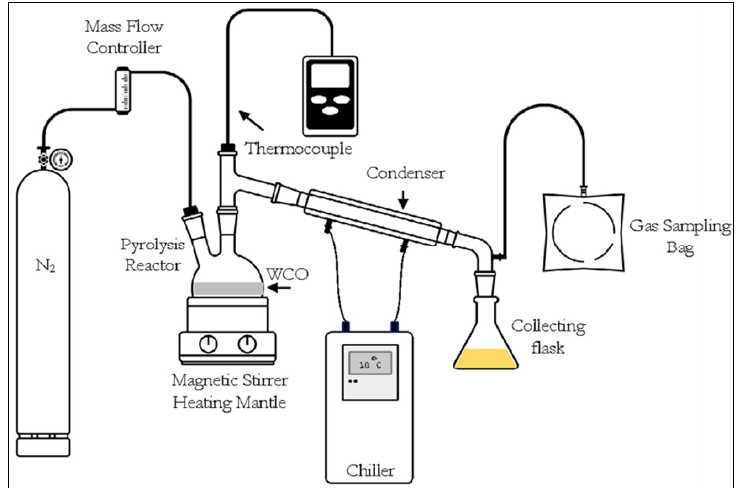
Figure 11. The schematic diagram of the experimental setup.